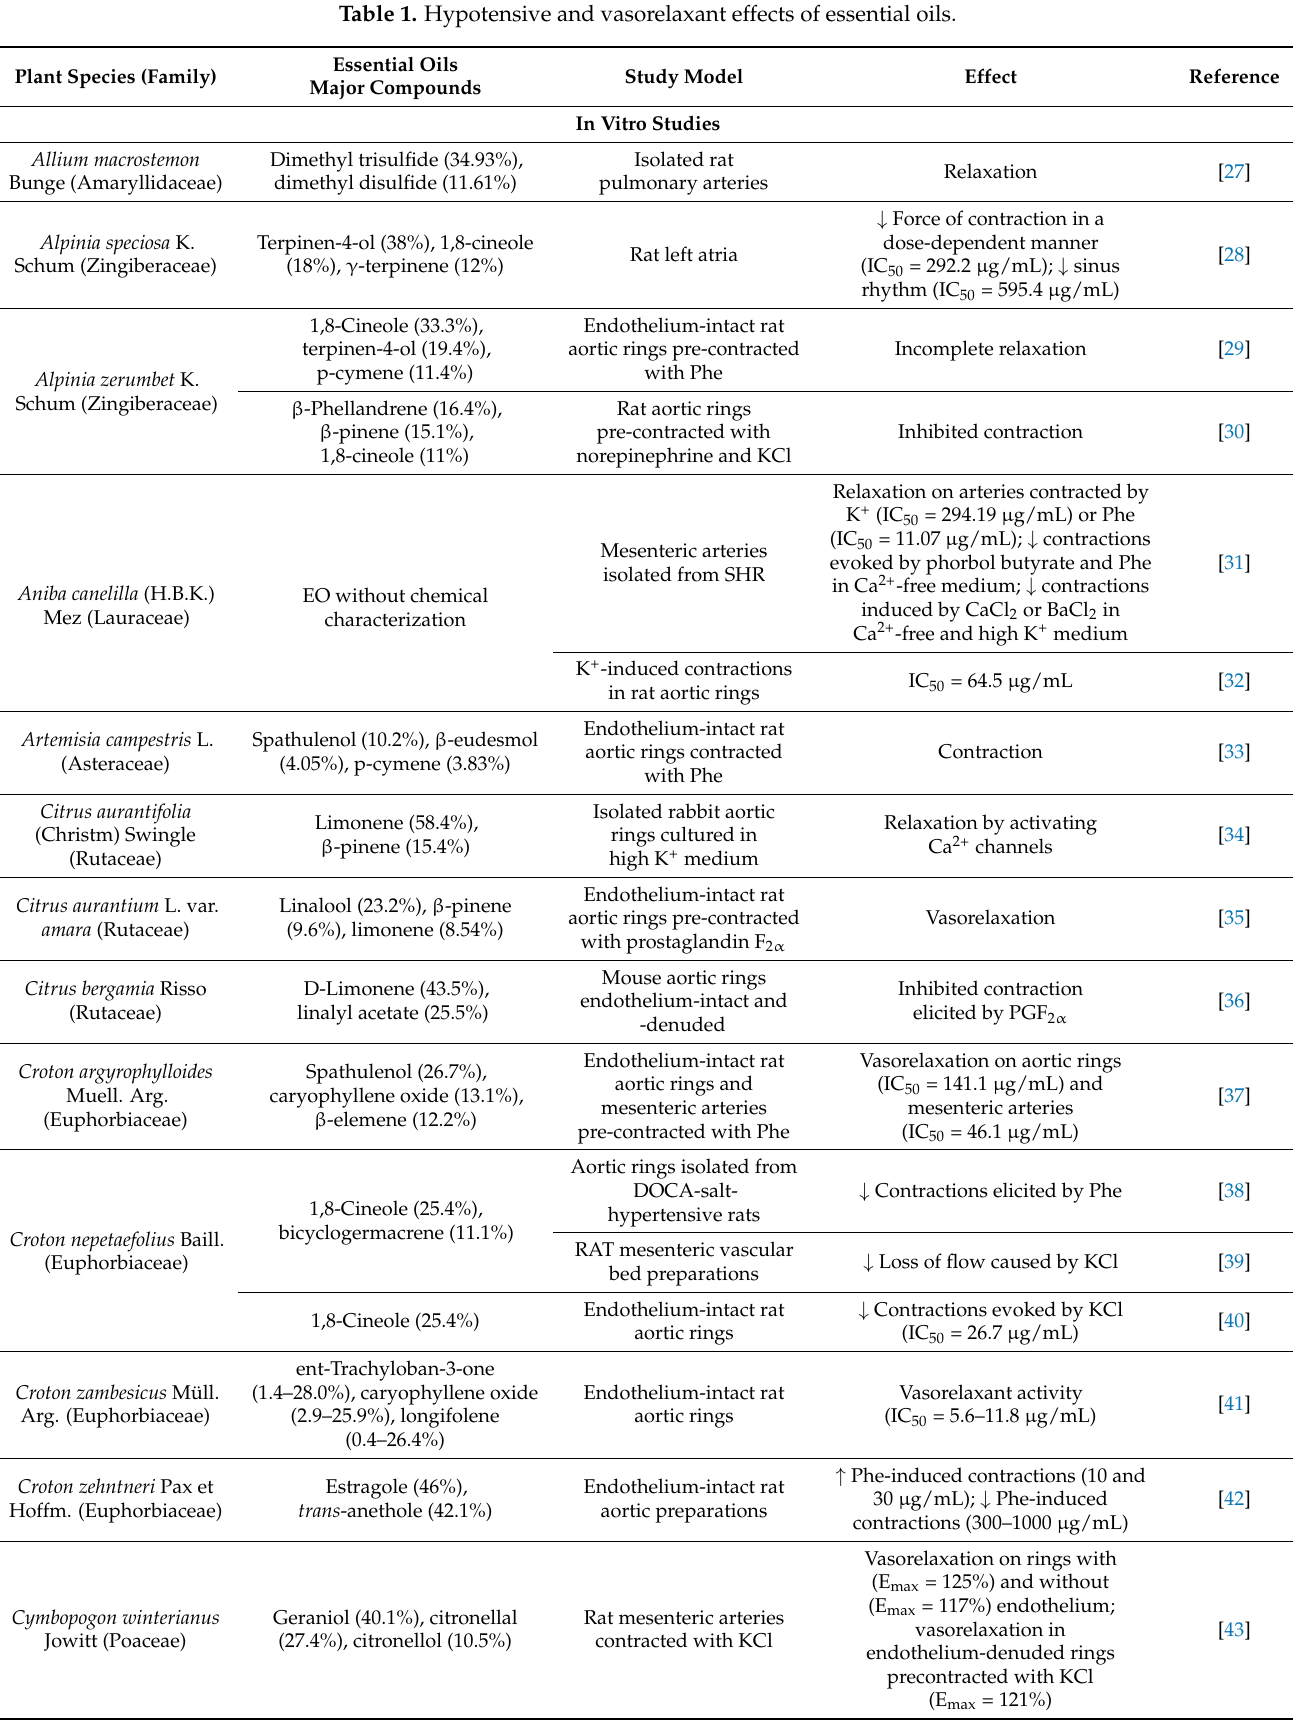
Table 1. Hypotensive and vasorelaxant effects of essential